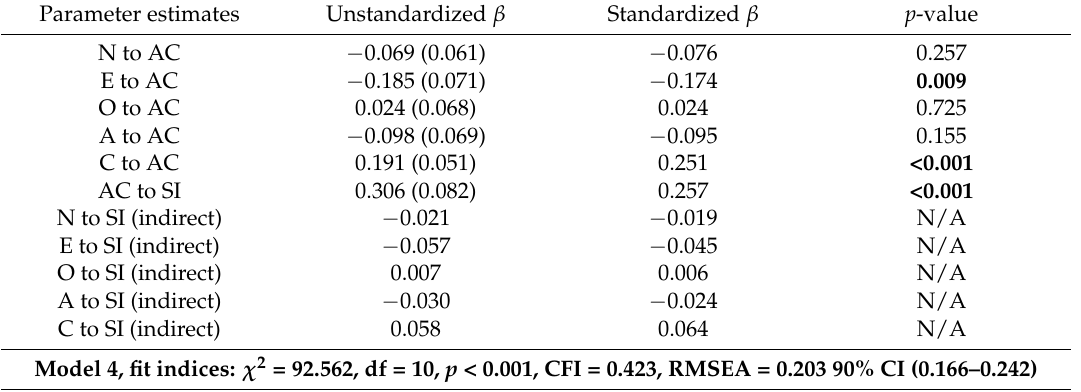
Table 3. Estimated unstandardized (with standard errors) and standardized parameters for the regression weights, as well as fit indices, for the two models with AC as mediator in the relationship between FFM variables and